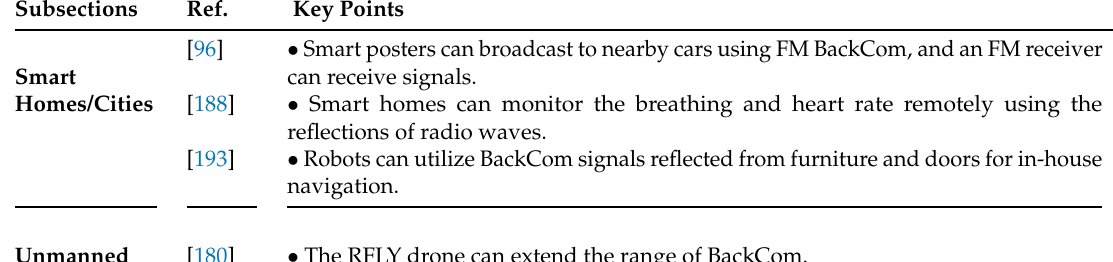
Table 12. Summary of BackCom